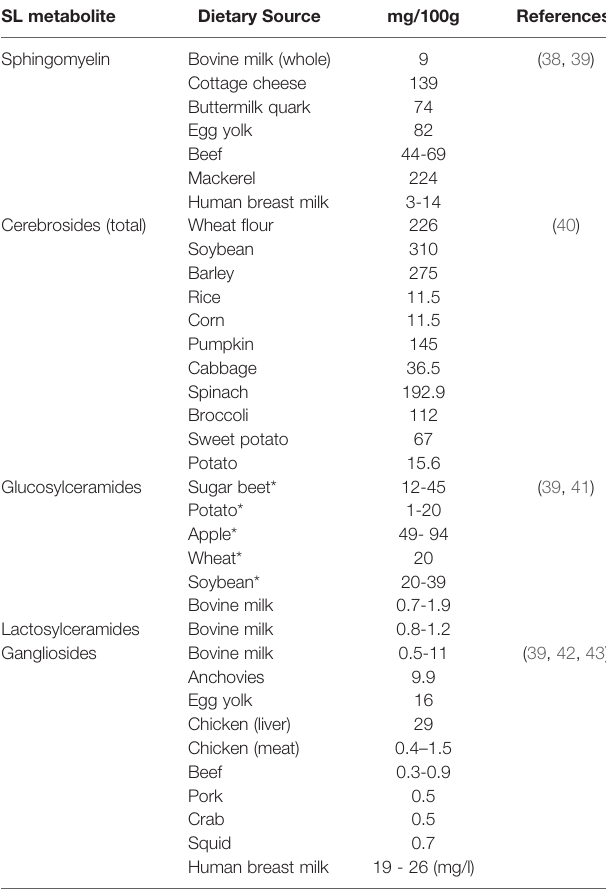
TABLE 1 | Summary of SL content in important food